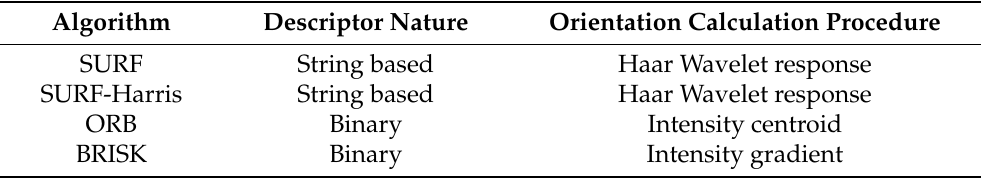
Table 2. Characteristics of the selected feature description procedures. ORB: Oriented Features from Accelerated Segment Test and Rotated Binary Robust Independent Elementary Features; BRISK: Binary Robust Invariant Scalable Keypoints.